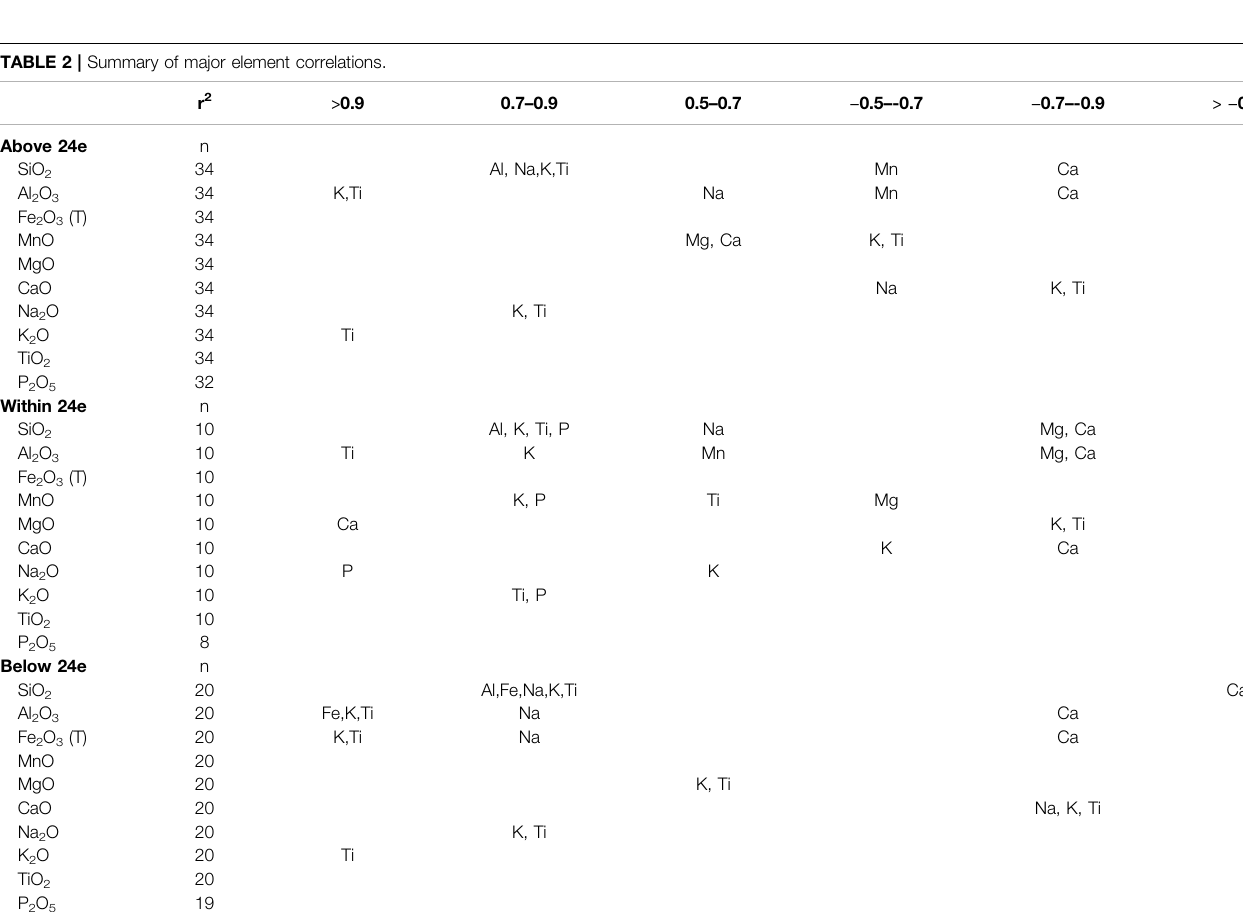
TABLE 2 | Summary of major element